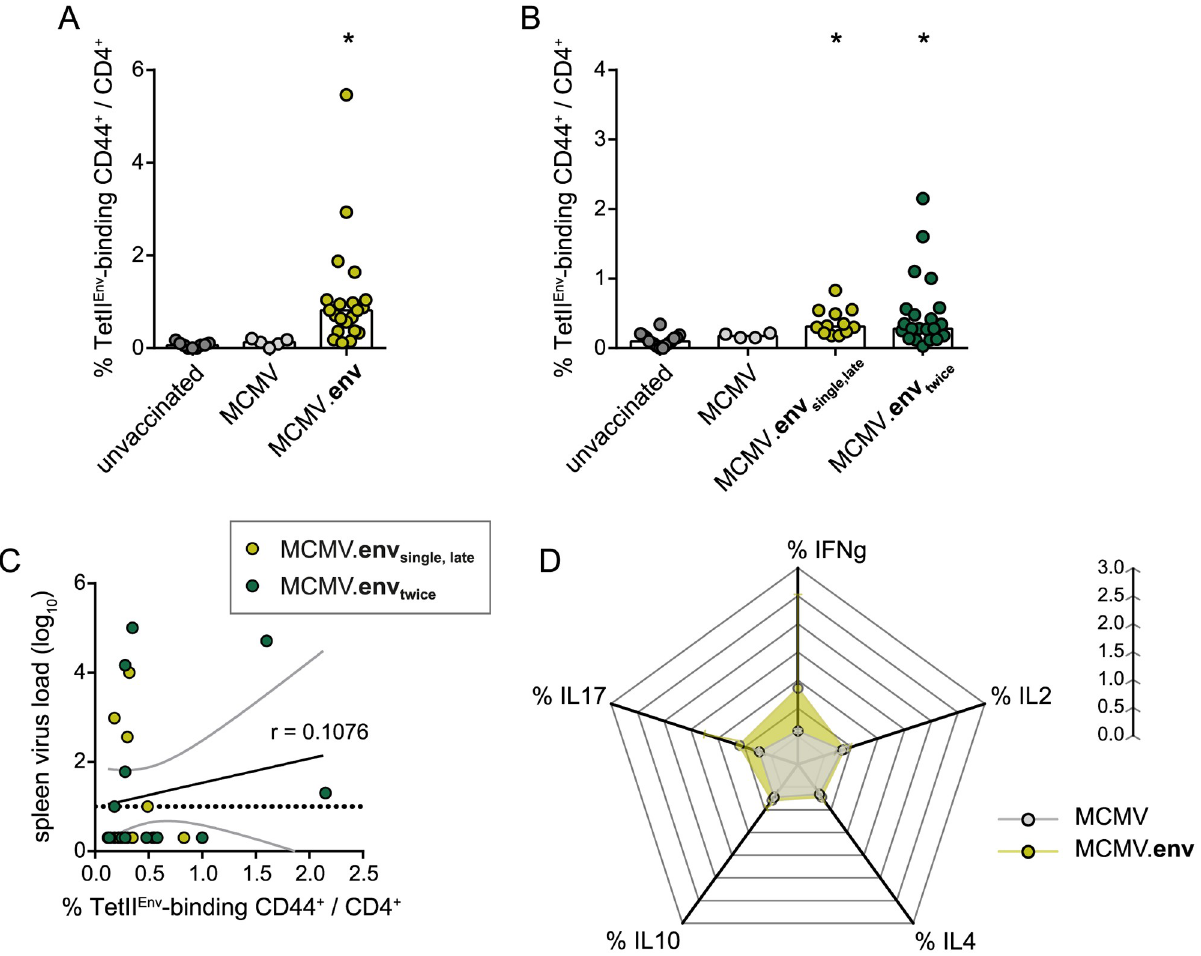
Fig 6. MCMV.env immunization leads to induction of strong Env 123-141 -specific CD4 + T cell responses. CB6F1 mice were immunized with MCMV.env, or a non-transgene-encoding control MCMV, either once, or twice in a three-week time interval, and Env-specific immune responses were analysed in peripheral blood cells by MHC II tetramer staining two weeks after the first immunization (A) or five weeks after the first immunization (B). (C) Correlation analysis of Env-specific CD4 + T cells shown in (B) and viral loads in spleens of immunized mice shown in Fig 4D. (D) Two weeks after the first immunization, cytokine production of CD4 + T cells from peripheral blood was analysed after in vitro restimulation with a pool of Env-derived peptides. (A-C) Each dot indicates an individual mouse, columns indicate the mean values, dotted line indicates the detection limit, grey lines indicate the 95% confidence interval. (A) Data were obtained in two (MCMV) or five independent experiments (MCMV.env, unvaccinated), using 5 (MCMV), 9 (unvaccinated) or 21 mice (MCMV.env) per group. (B) Data were obtained in two (MCMV), three (MCMV.env single,late ) or five independent experiments (MCMV.env twice , unvaccinated), using 4 (MCMV), 12 (MCMV.env single,late ) or 14 mice (unvaccinated, MCMV.env twice ) per group. (D) Data were obtained in one experiment; dots indicate mean values, whiskers indicate the standard deviation. Statistically significant differences compared to unvaccinated mice are indicated by � ( P < 0.05, One Way ANOVA on Ranks, Dunn’s post